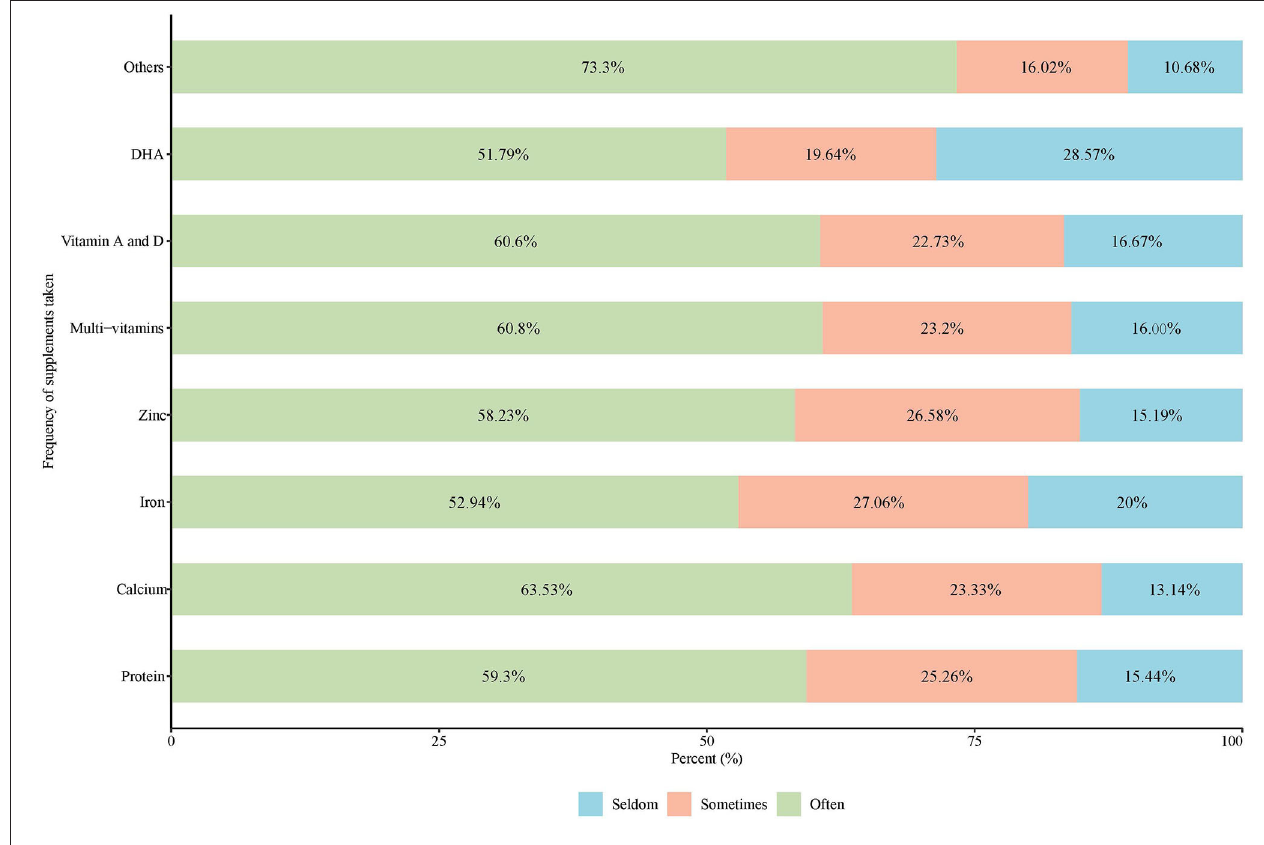
FIGURE 3 | Distribution of the supplements taken by